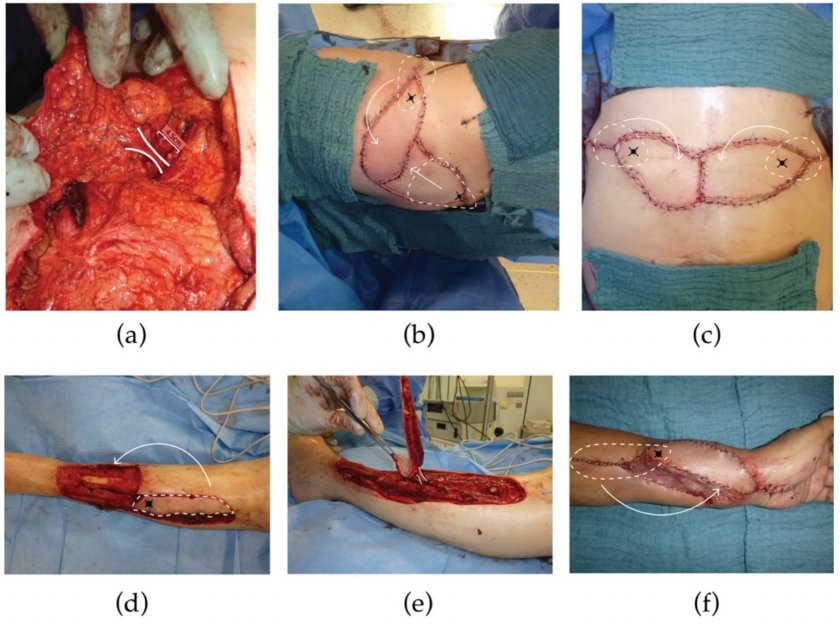
Figure 1. Principle of flap harvesting. ( a – c ) demonstrates PPF reconstruction on the trunk. ( a ) Metic- ulous dissection of the perforator. We aimed for a minimum length of 3 to 5 centimeters to avoid vascular complications; ( b ) PPF plus perforator-based VY advancement flap. Black crosses indicate perforators of the flaps. After skin incision and dissection of surrounding tissue, the PPF was rotated (curved arrow) into the defect, while the VY advancement flap was transposed (straight arrow) into the defect; ( c ) Double PPF: Black crosses indicate pivot points given by the perforators. Those were marked together with the regions of flap harvesting (white dashed lines) prior to surgery. After skin incision and dissection of surrounding tissue, flaps were rotated into the defect (white dashed lines); ( d , e ) Demonstrates PPF reconstruction of the lower extremity; ( f ) Demonstrates PPF reconstruction of the upper extremity (Abbreviations: PPF, perforator propeller